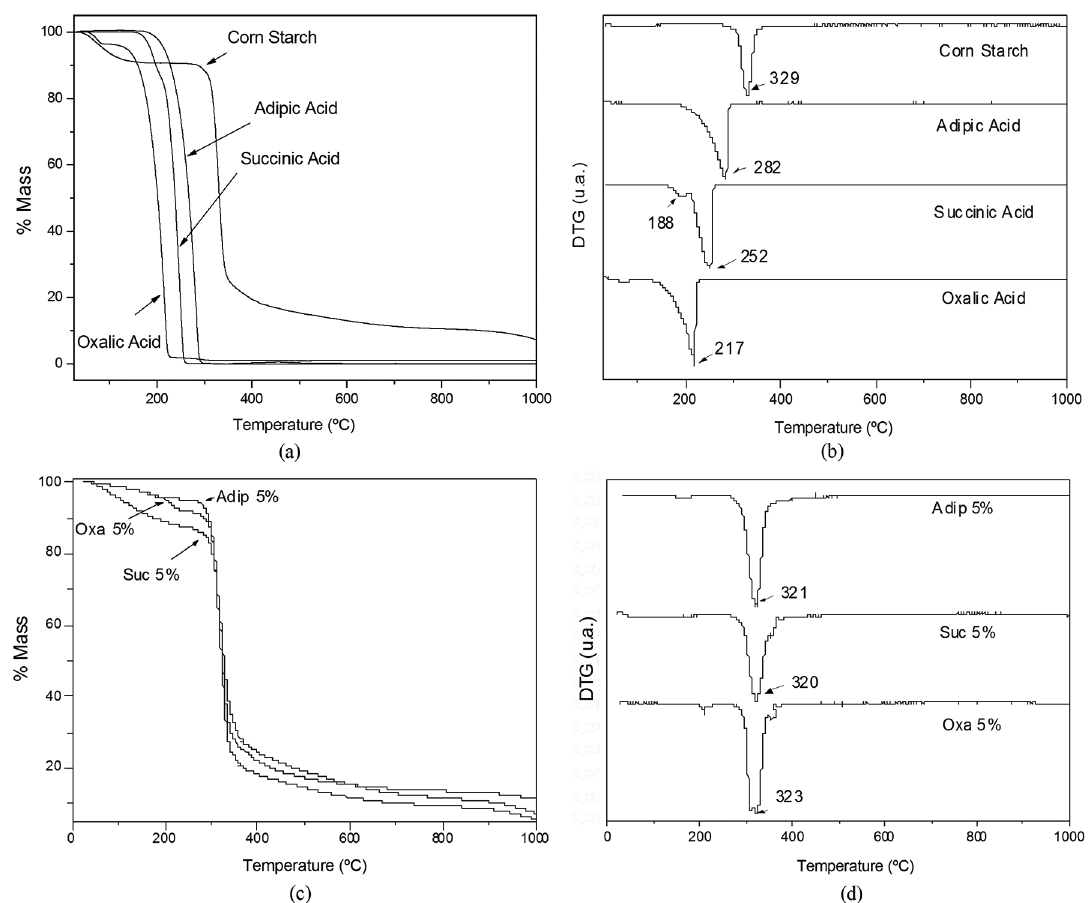
Figure 1. TG and DTG curves of the precursors and